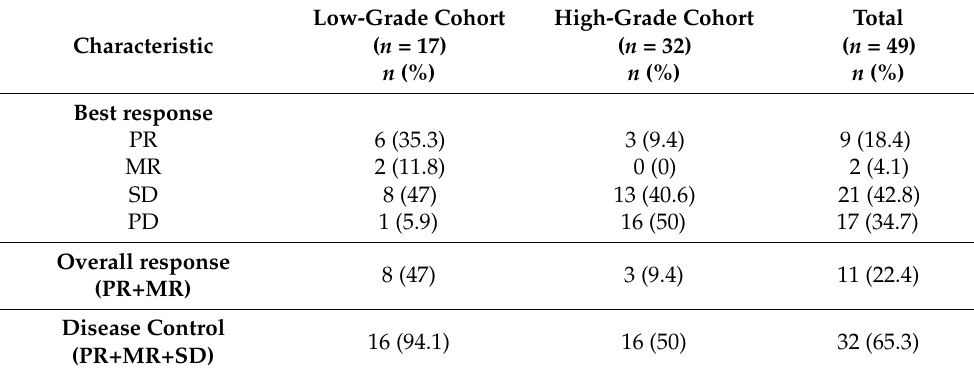
Table 2. Best response according to